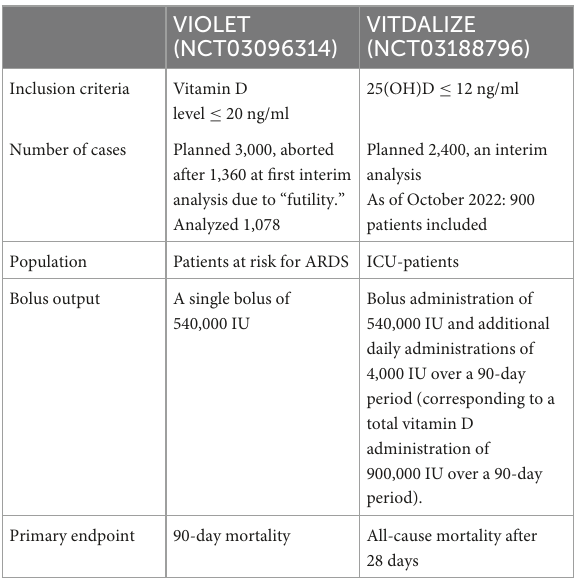
TABLE 2 Comparison of the large intervention studies VIOLET and VITDALIZE—two studies that at first glance appear similar, but nevertheless have significant differences, regarding drug administration, inclusion criteria, and primary